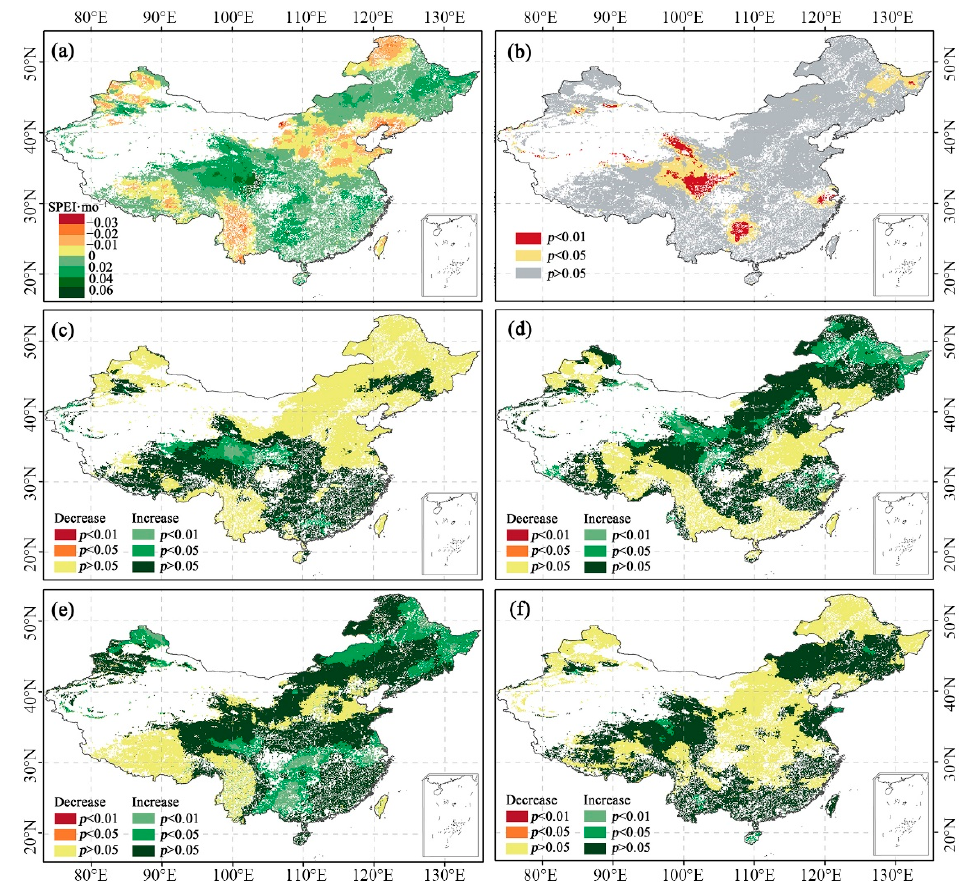
Figure 2. Spatial distribution of annual ( a ) changing trend, ( b ) p -value, and seasonal changing trend in ( c ) spring, ( d ) summer, ( e ) autumn, and ( f ) winter across China from 2001 to 2020 using the standardized precipitation evapotranspiration index (SPEI) based on the Mann–Kendall (M–K) trend test .